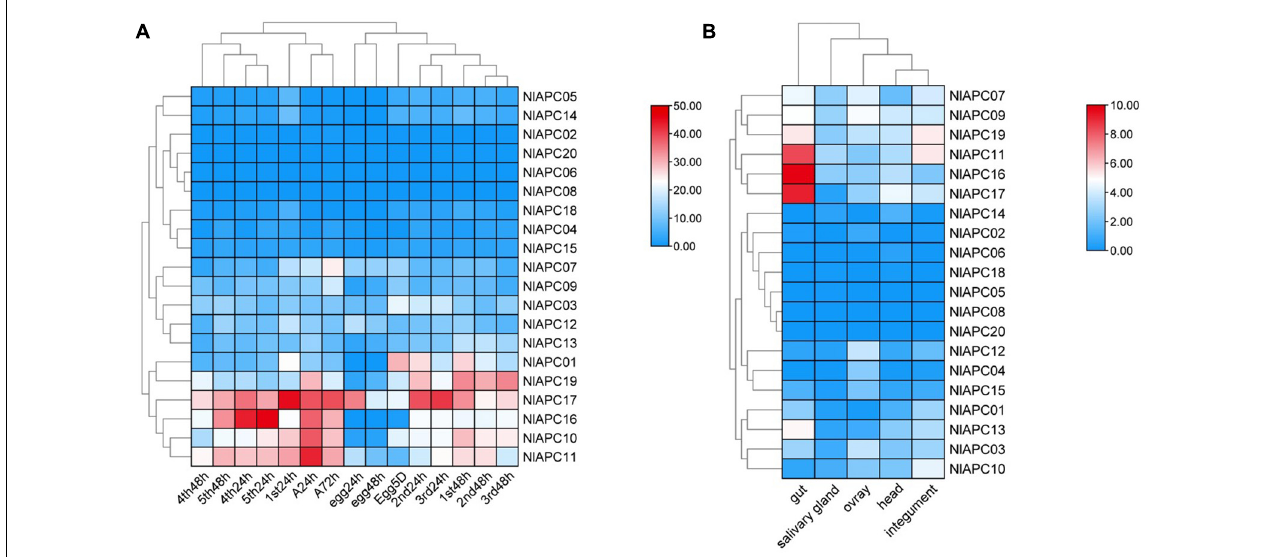
FIGURE 5 | Spatiotemporal expression profiling of identified APC transporter genes in BPH based on large-scale transcriptome data. Kallisto v0.46.1 was used to calculate the TPM (the transcript abundance in transcripts per million) value for each identified APC gene base on the RNA-seq data downloaded from NCBI database. (A) Developmental stage-specific expression patterns of APC genes in BPH. (B) Tissue-specific expression patterns of APC transporter genes in BPH. Log 2 (TPM + 1) was used to scale the gene expression level of each APC transporter in different